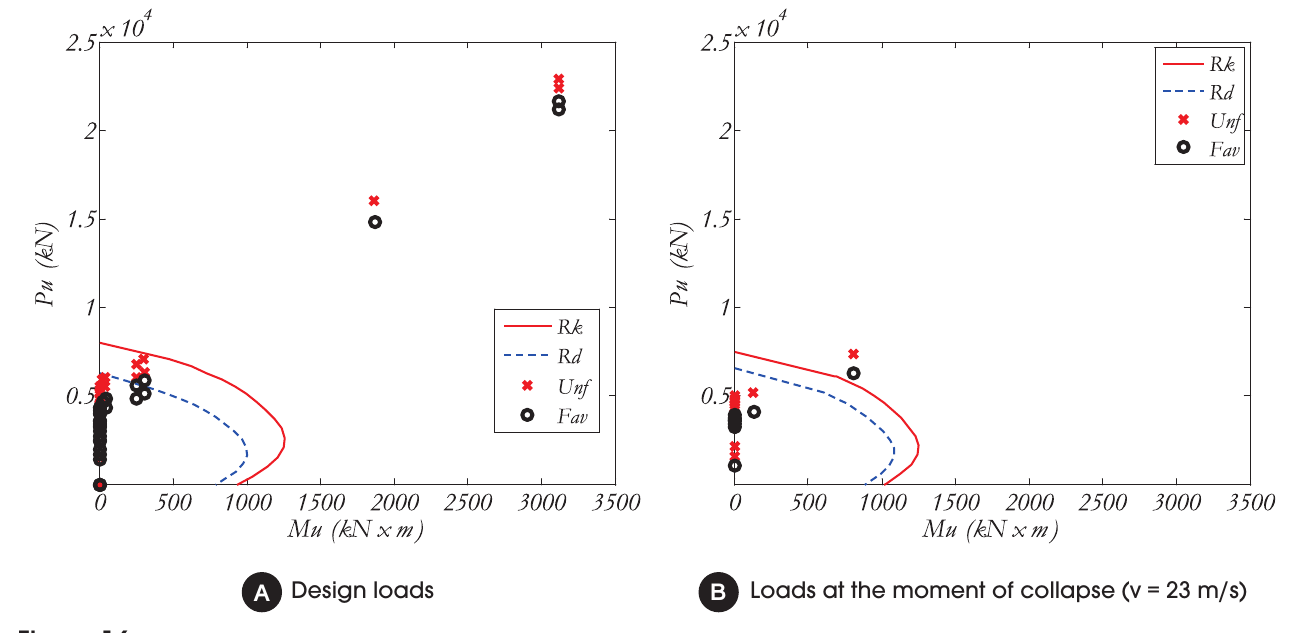
A Design loads B Loads at the moment of collapse (v = 23 Figure 16 Interaction diagram of column P04